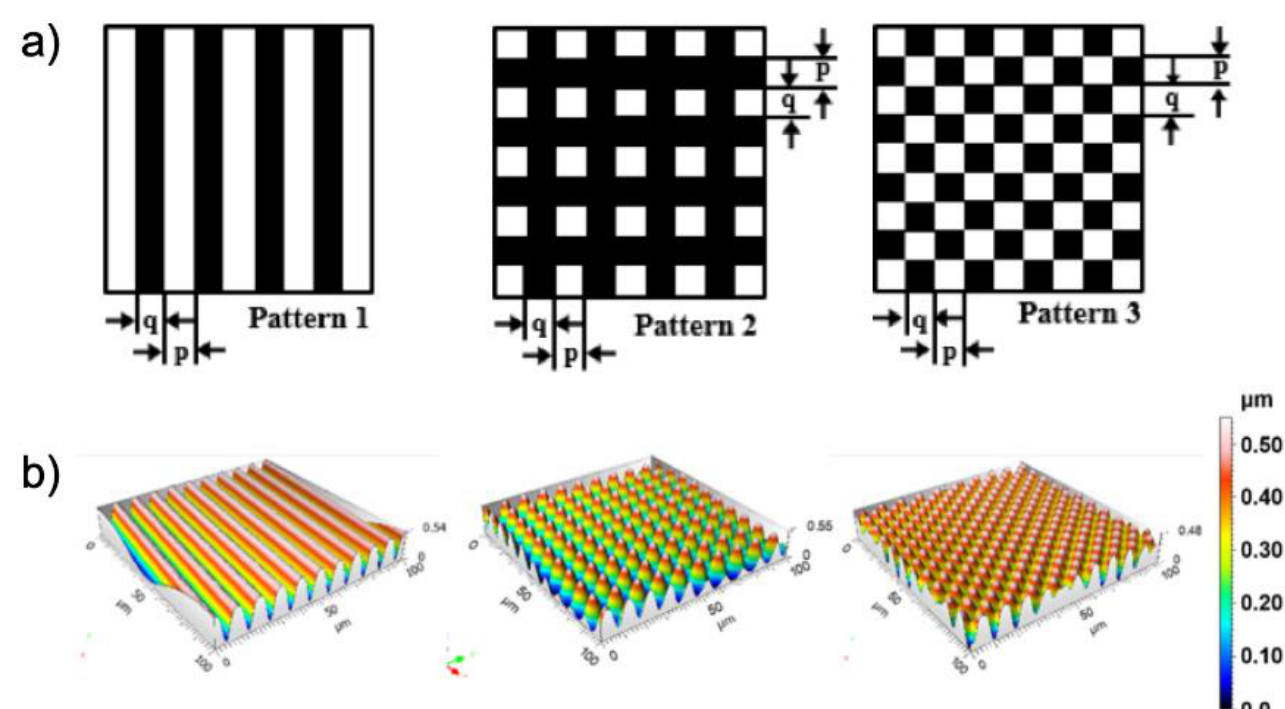
Figure 3. ( a ) Schematic of three pattern masks. The black part represents the masked area where the UV light is blocked. The period of photo-embossed structure is defined as p + q, where p = q in the current study; ( b ) the corresponding three-dimensional topographies of the photo-embossed surface reliefs. Table 1. Structure sizes measured for the four samples treated with different solvent developing conditions, and a control sample without any solvent treatment. The line pattern with 10 µ m period is used for all the samples. Sample